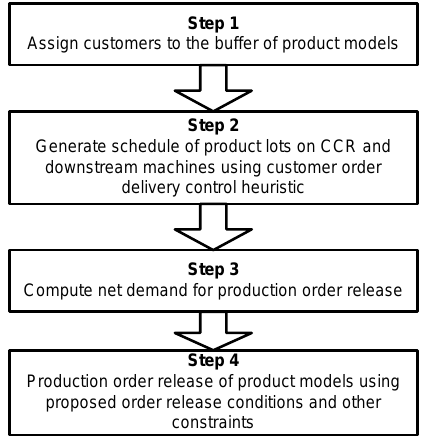
Figure 2. Steps of the proposed heuristic algorithm.